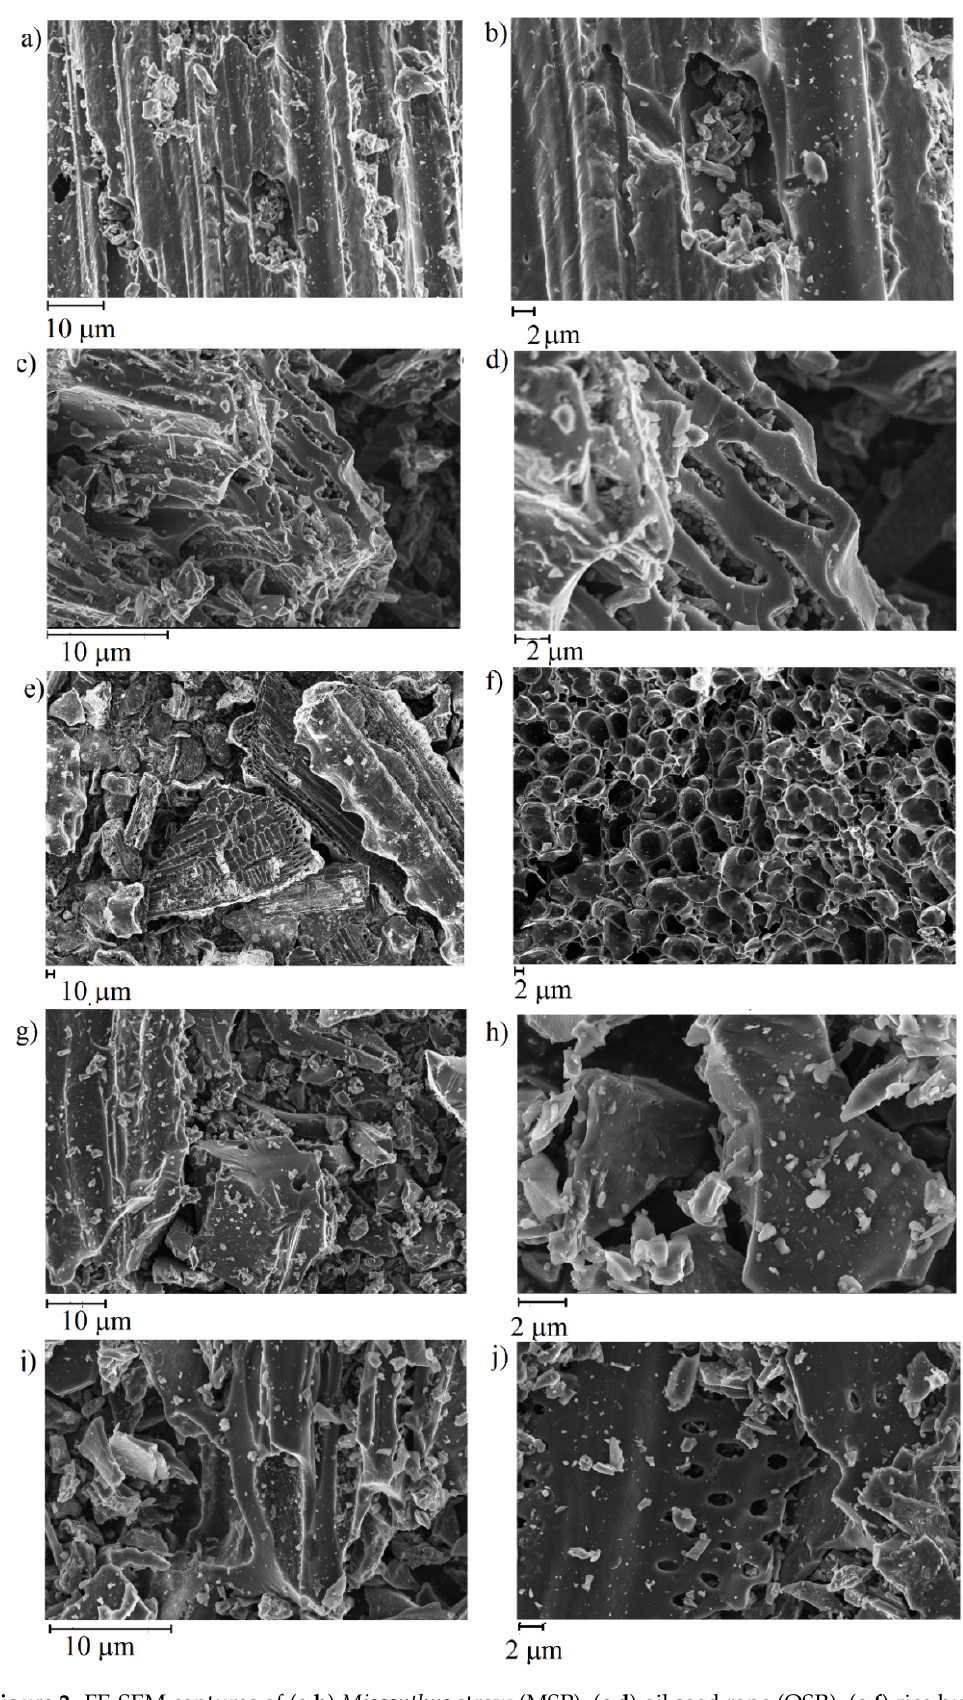
Figure 2. FE-SEM captures of ( a , b ) Miscanthus straw (MSP), ( c , d ) oil seed rape (OSR), ( e , f ) rice husk (RH), ( g , h ) mixed softwood (SWP), and ( i , j ) wheat straw